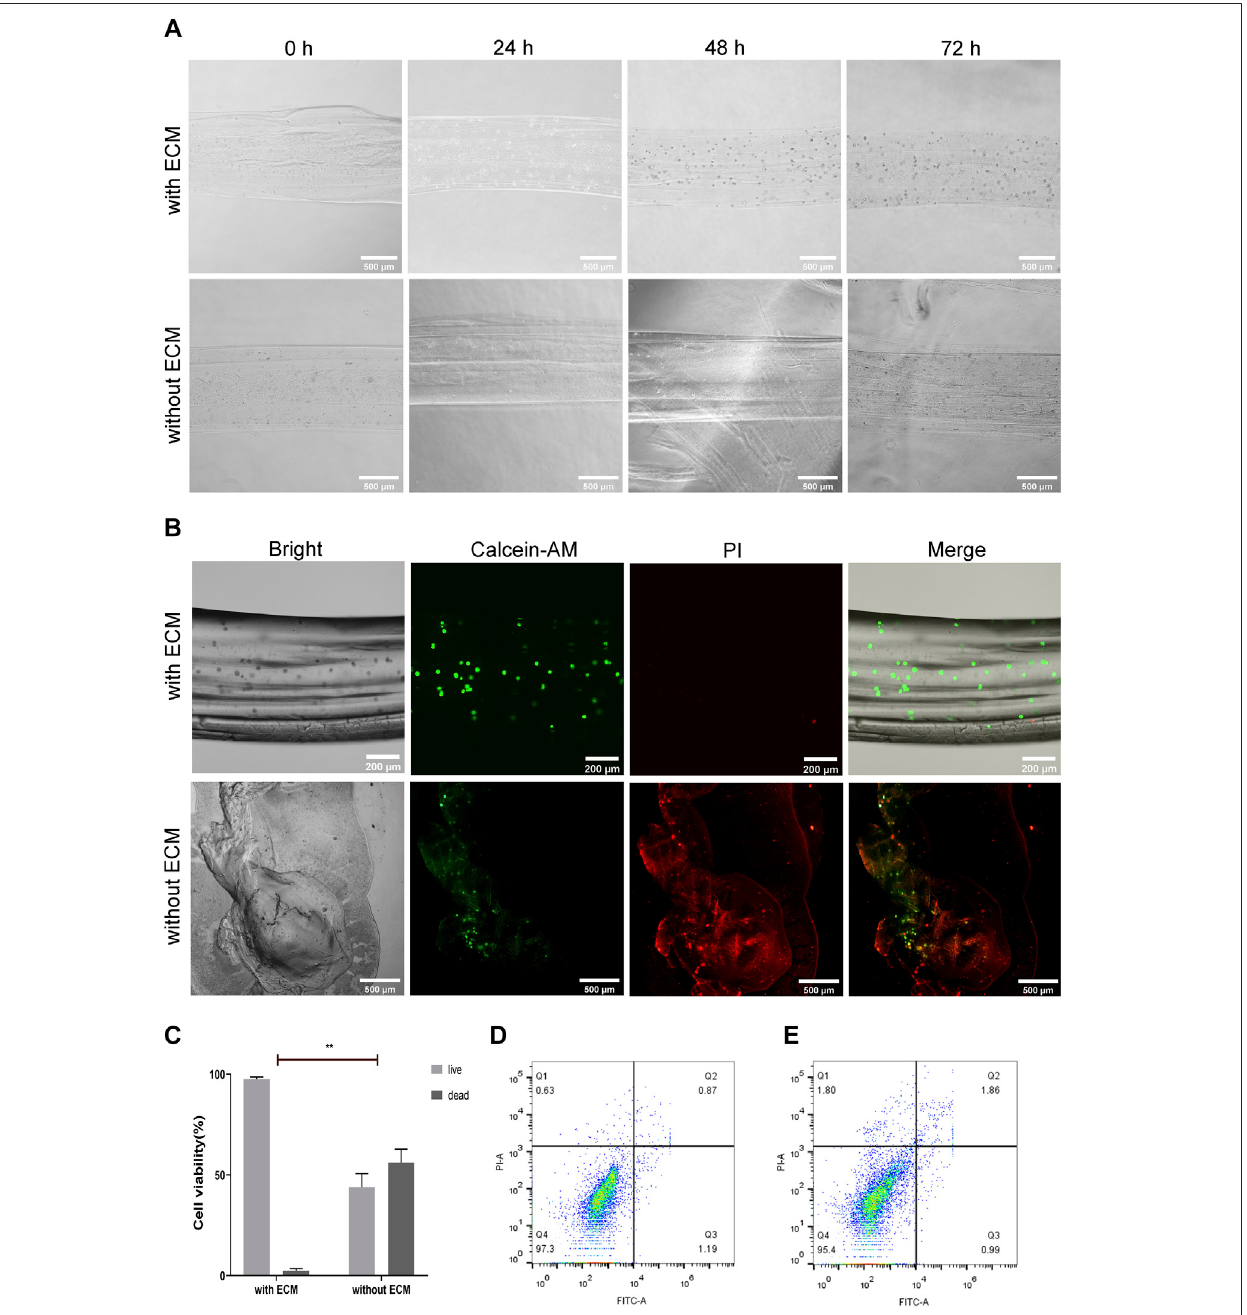
FIGURE6| BiocompatibilityofHydrogelMicrotubules (A) ThemicrographsofalginatehydrogelmicrotubesencapsulatedwithCal27cells,withorwithoutECM,at 0, 24, 48 and 72 h, the scale is 500 μ m (B) Cal27 cells were encapsulated in alginate hydrogel microtubes with or without ECM and cultured for 72 h. Live cells were labeled with green fl uorescence by Calcein-AM and dead cells were labeled with red fl uorescence by PI, the scales are 200 and 500 μ m, respectively (C) Quantitative analysis of live and dead cell staining (D,E) Apoptosis was detected by fl ow cytometry after 48 and 72 h of culture with Annexin V-FITC/PI staining. The apoptosis rate was low in the algnate hydrogel with ECM